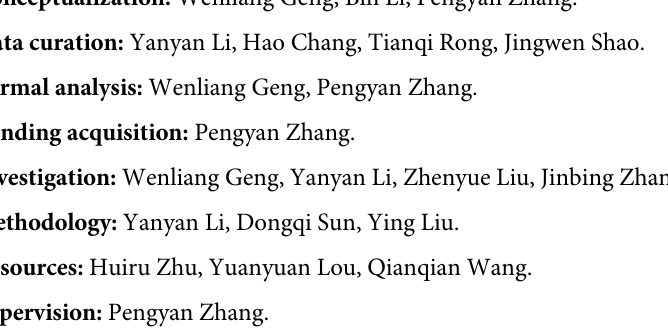
S2 Table. Primitive environmental variables were used to predict the potential geographic distribution of Betula platyphylline